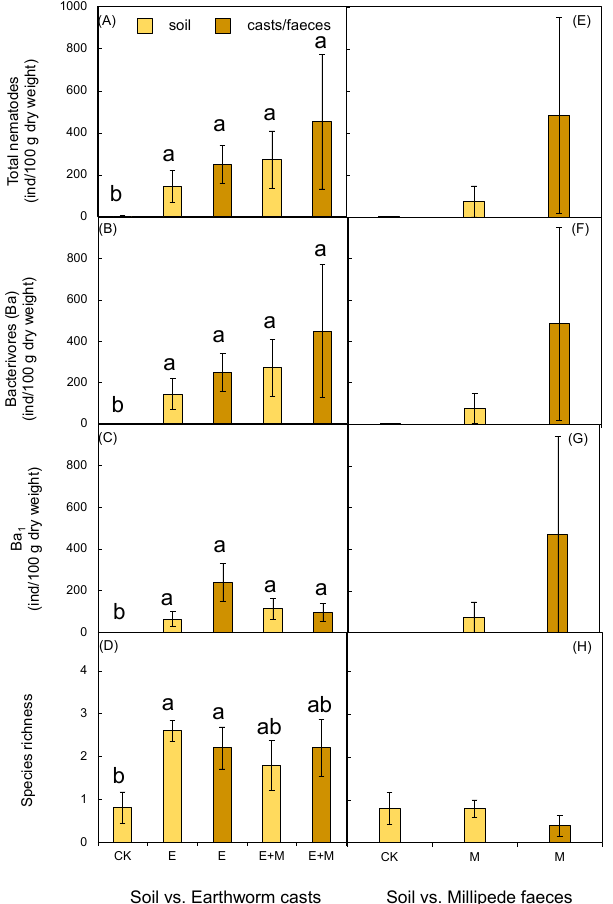
Figure 3. Comparison of the abundance and species richness of the nematodes between the soil and earthworm casts and the millipede feces. ( A , E ) Total nematodes abundance; ( B , F ) the abundance of bacterivores; ( C , G ) the abundance of Ba 1 guild of the bacterivores; ( D , H ) number of the nematode species. Data represent means ± SE (n = 5). Significant ( p < 0.05) effects based on one-way ANOVA are presented by lowercase letters. No millipede feces was found sample receiving E + M treatment.